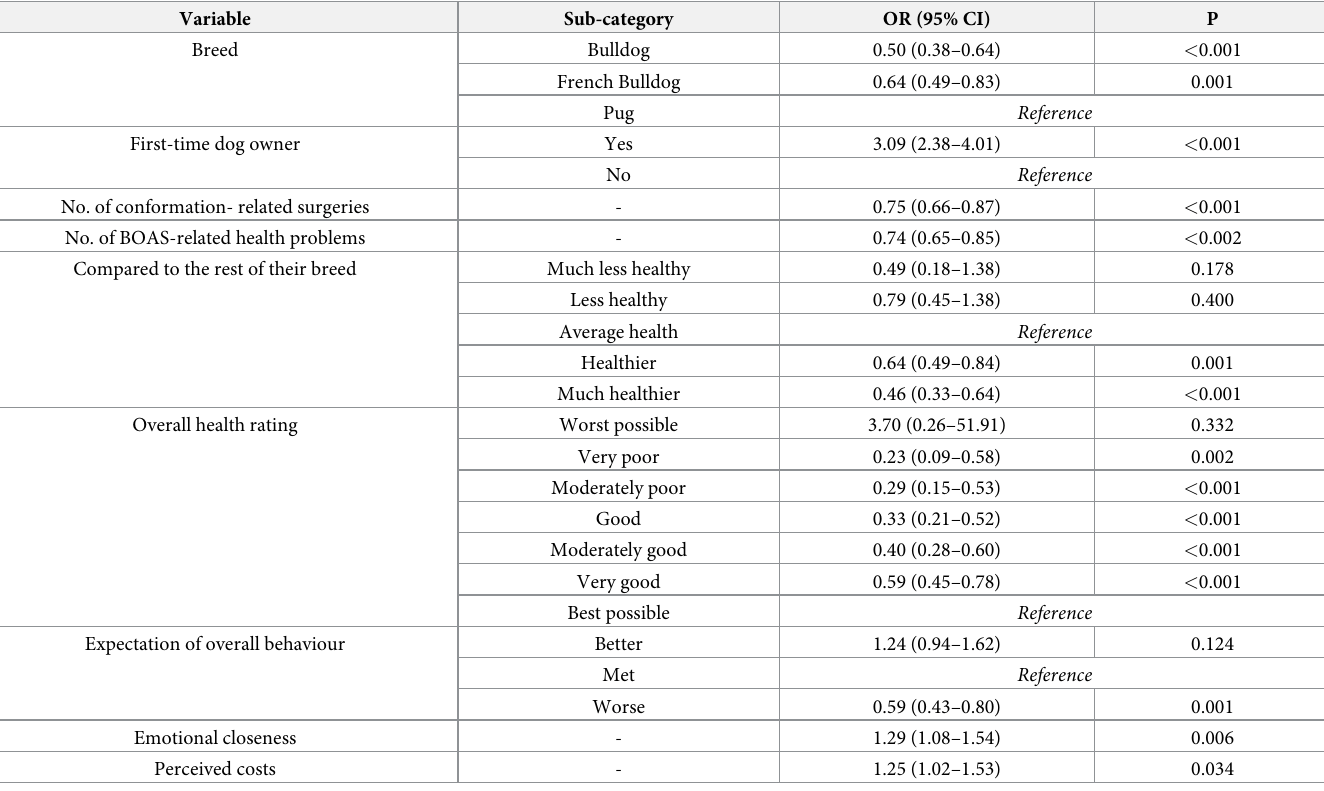
Table 2. Results of multivariable binary logistic regression for risk factors associated with owner desire to recommend their current breed to a potential first-time owner.